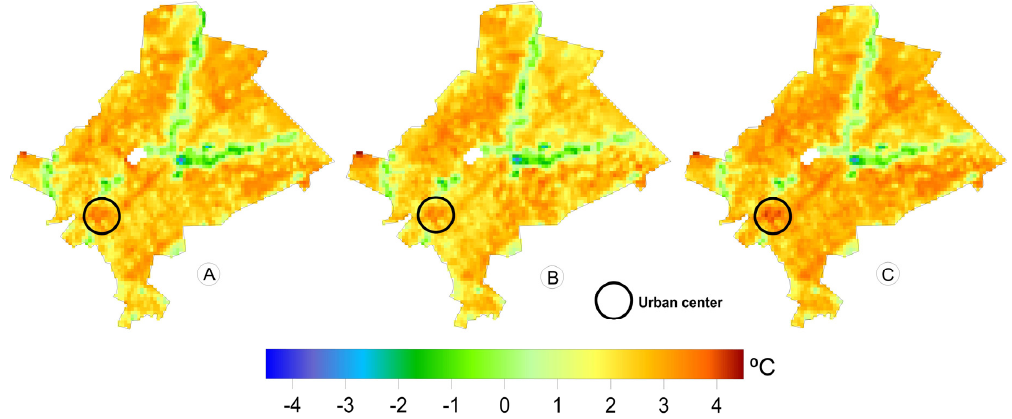
Figure 5. Thermal patterns estimated on the 21 October 2014, at 20:30 ( A ); 21:00 ( B ); and 21:30 ( C ).